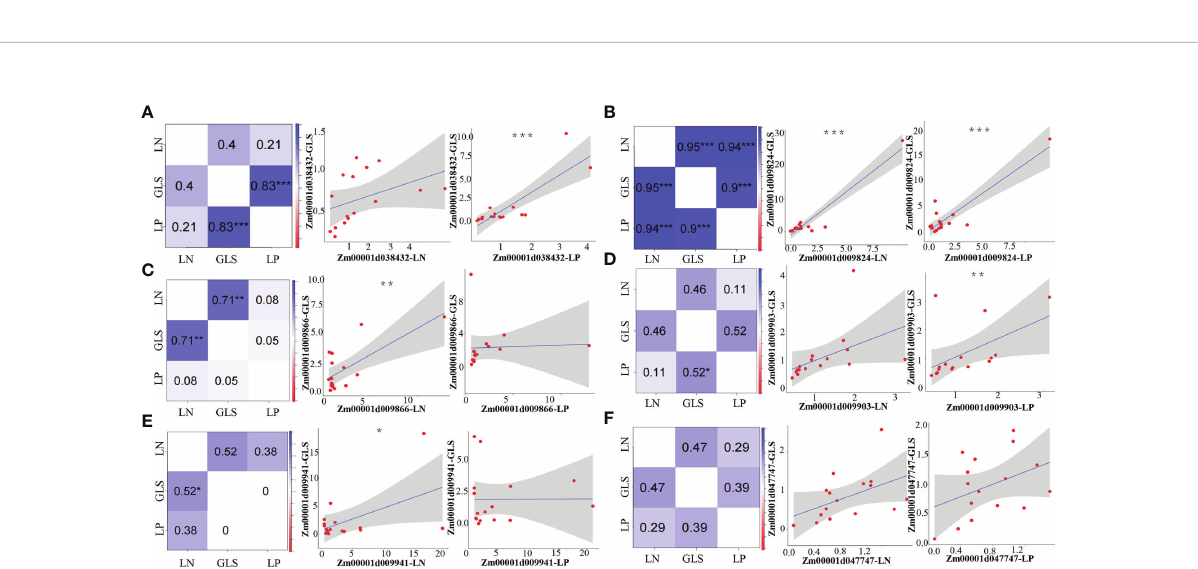
FIGURE 4 Pearson correlation analysis between nutrition and GLS treatments of candidate genes. (A) Correlation results of Zm00001d038432 under nutrition and GLS treatments. (B) Correlation results of Zm00001d009824 under nutrition and GLS treatments. (C) Correlation results of Zm00001d009866 under nutrition and GLS treatments. (D) Correlation results of Zm00001d009903 under nutrition and GLS treatments. (E) Correlation results of Zm00001d009941 under nutrition and GLS treatments. (F) Correlation results of Zm00001d047747 under nutrition and GLS treatments. LP, Low phosphorus; LN, Low nitrogen; GLS, Gray leaf spot. *5% signi fi cance level, **1% signi fi cance level, ***0.1% signi fi cance level.